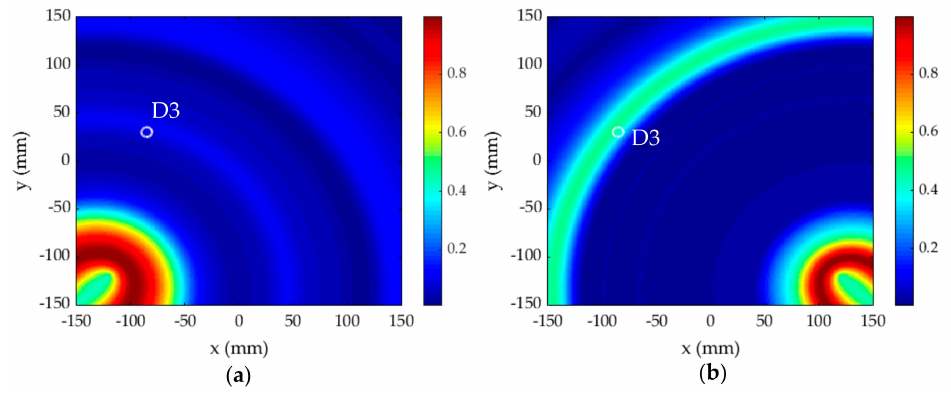
Figure 28. Possibilities of damage existence for sensing path: ( a ) A1B1; ( b )